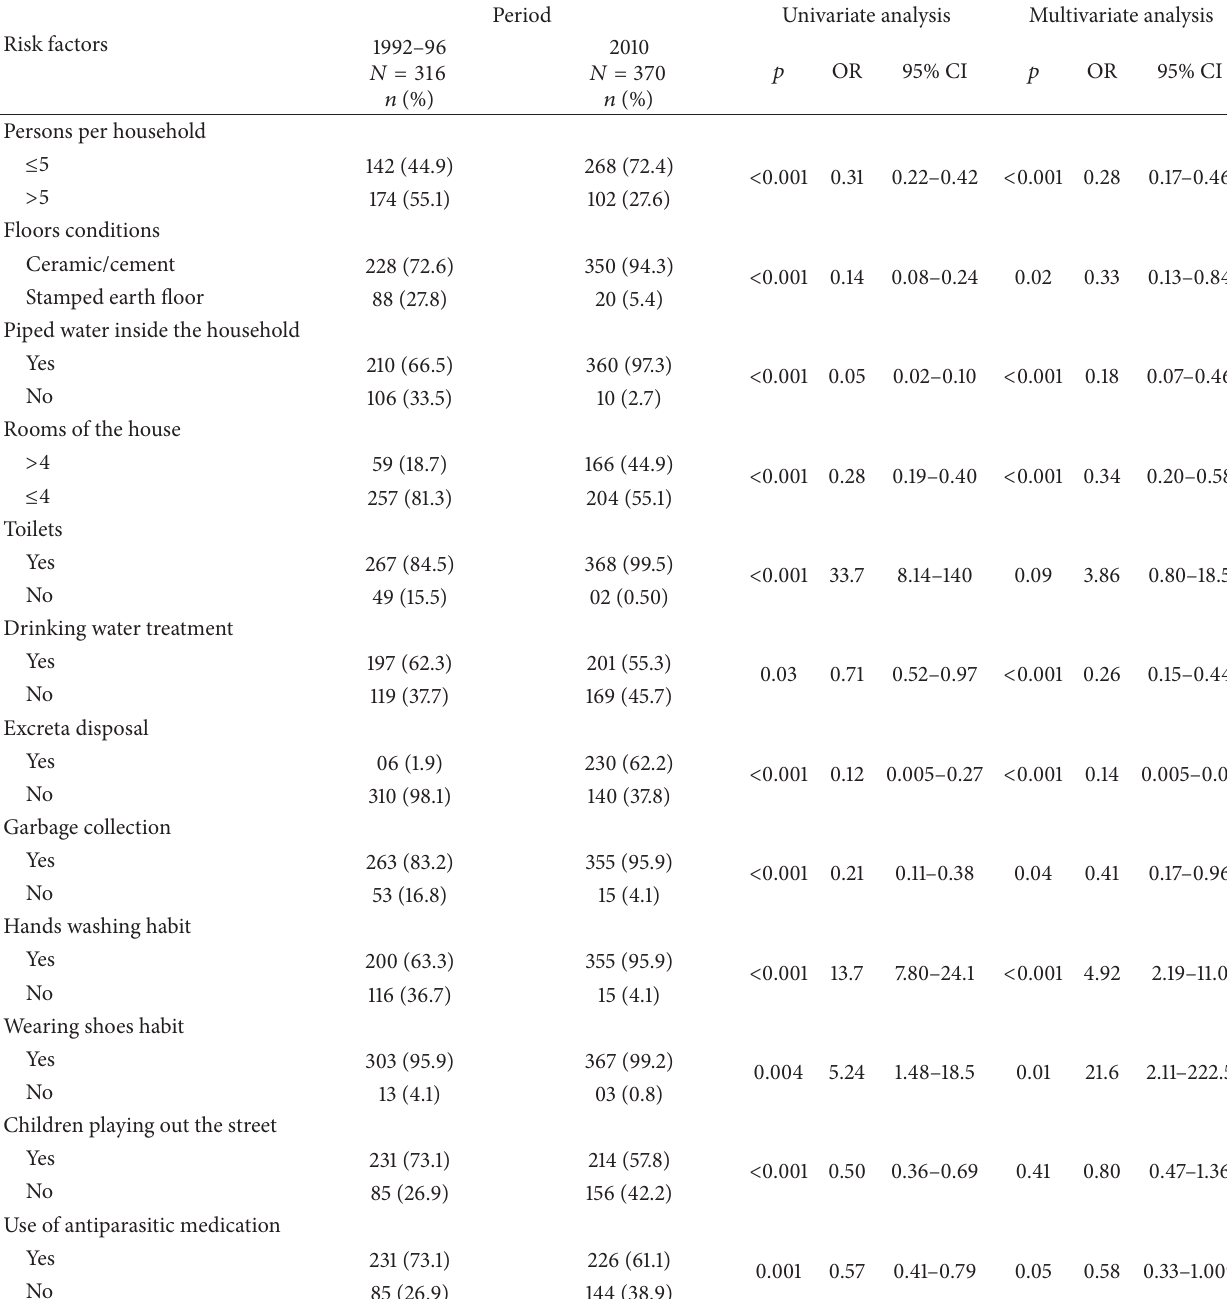
Table 2: Prevalence of potential risk factors collected in the period 1992–1996 and in 2010, Northeast